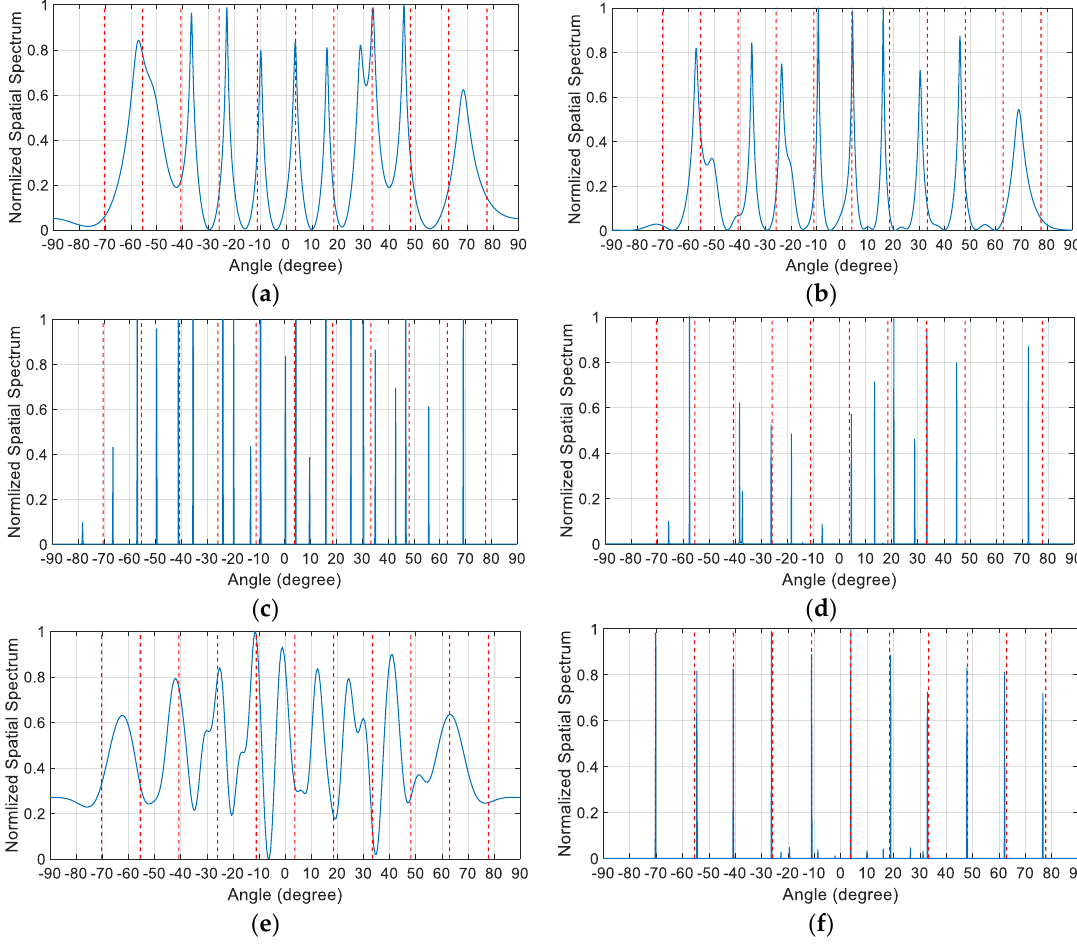
Figure 3. Normalized spatial spectrum comparison with SNR = 30dB and the number of snapshots. T = 2000 when K = 11 and M = { 4,6,8 } . ( a ) SS-MUSIC algorithm; ( b ) NNM algorithm; ( c ) SSR algorithm; ( d ) SBAC algorithm in Ref. [17]; ( e ) SBAC algorithm in Ref. [21]; ( f ) Proposed